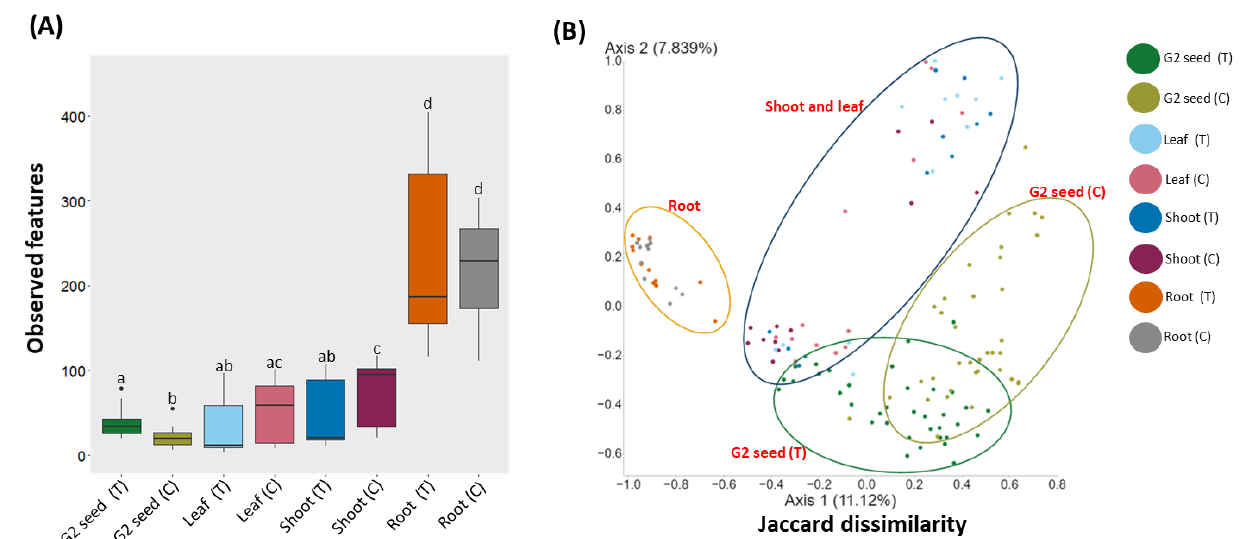
Figure 5. Alpha- (observed features) and β -diversity (Jaccard dissimilarity) analyses of G. clandestina plant organs for plants grown in two soil treatments (T and C). ( A ) “Box-and-Whiskers” plots visualize the observed features for plant organs. Significant differences ( p ≤ 0.05) were assessed by the Kruskal Wallis pairwise test and are indicated by lower-case letters. ( B ) PCoA plots showing the distances between the bacterial community composition of G1 plant organs and G2 seed when grown in two soil treatments (T and C). Significant differences in bacterial composition were tested using the ANOSIM pairwise test. Different colours of the bars ( A ) and points ( B ) represent the G1 plant organs and G2 seed when grown in two soil treatments (T and C).